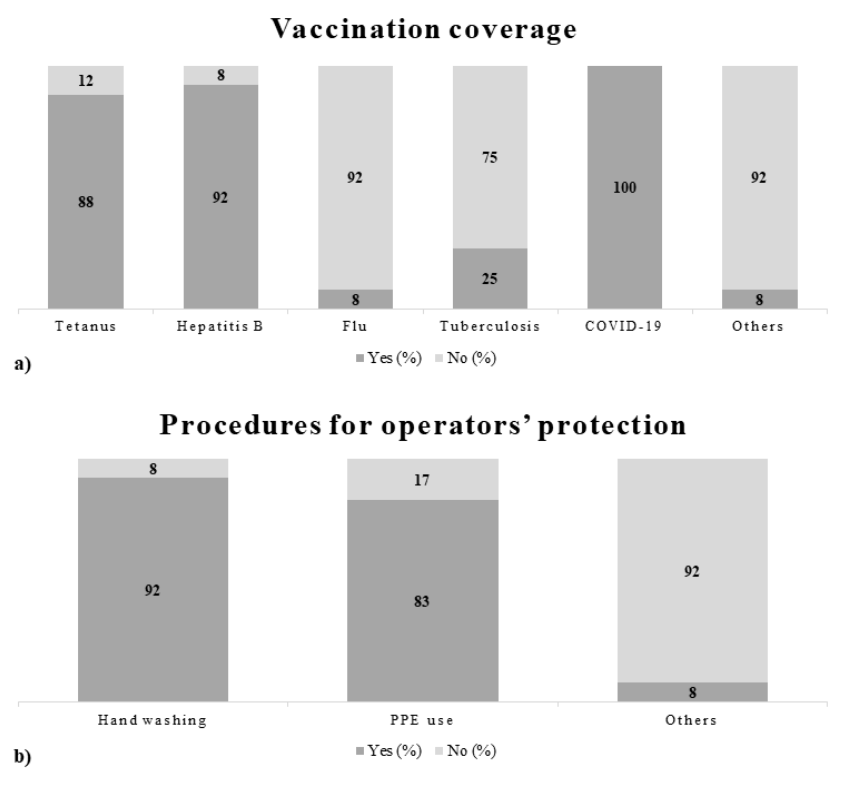
Figure 3. ( a ) Data on vaccination coverage; ( b ) data on the presence of written procedures for workers’